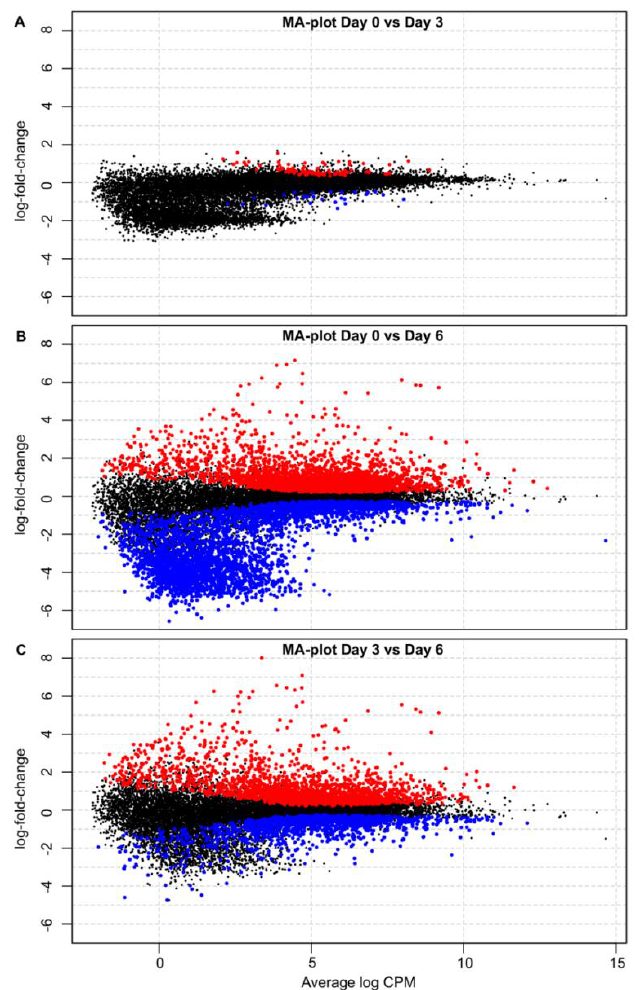
Figure 3. Changes in host gene expression in PBMCs from ASFV-infected pigs. MA plots showing the log 2 -fold change in mean gene expression (average log 2 counts per million (CPM) at different times post-inoculation. ( A ) PBMCs from pigs 0 dpi vs. 3 dpi. ( B ) PBMCs from pigs at 0 dpi vs. 6 dpi. ( C ) PBMCs from pigs at 3 dpi vs. 6 dpi. Red and blue data points show genes that were found by EdgeR to be expressed at a significantly higher or lower level, respectively. Black data points show genes that are not significantly changed. The plots were made using the glmQL model in EdgeR and assembled in